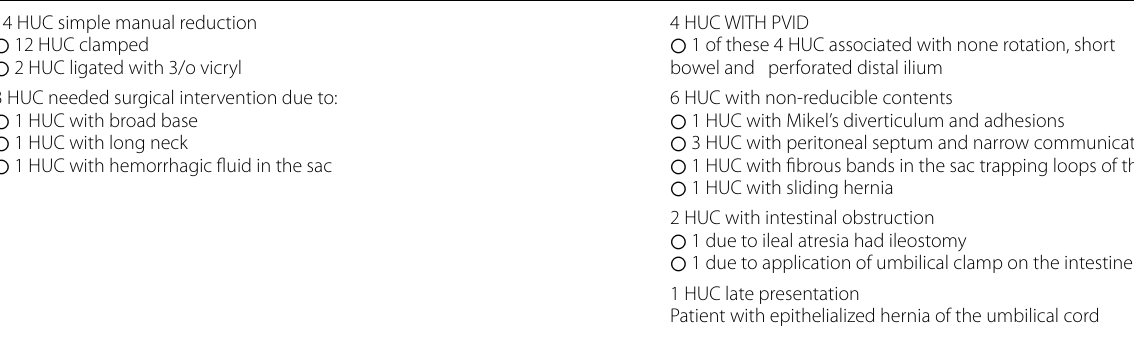
Table 1 Summary of the 30 cases of hernia of the umbilical cord